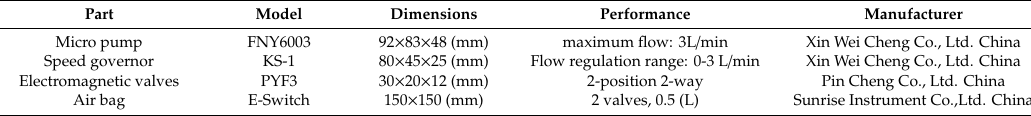
Table 1. Introduction to main parts of gas sampling equipment.